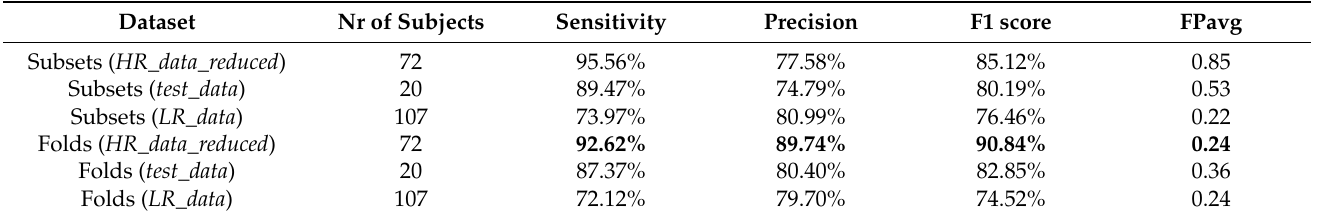
Table 7. Test results depending on defining a training dataset. (The best result is marked in